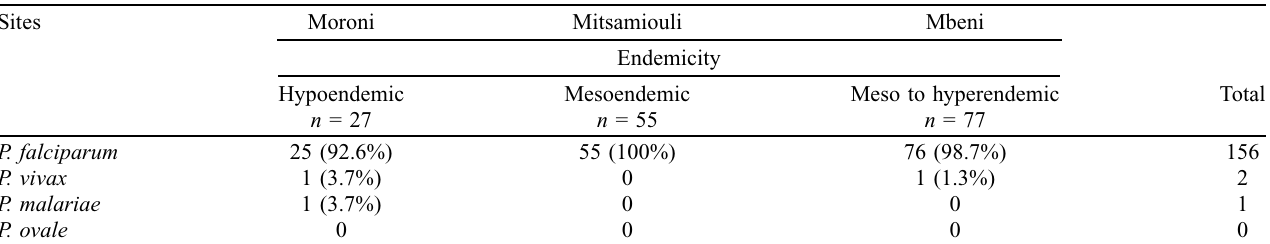
Table 1. The distribution of Plasmodium species in the three regions of the island of Grande Comore